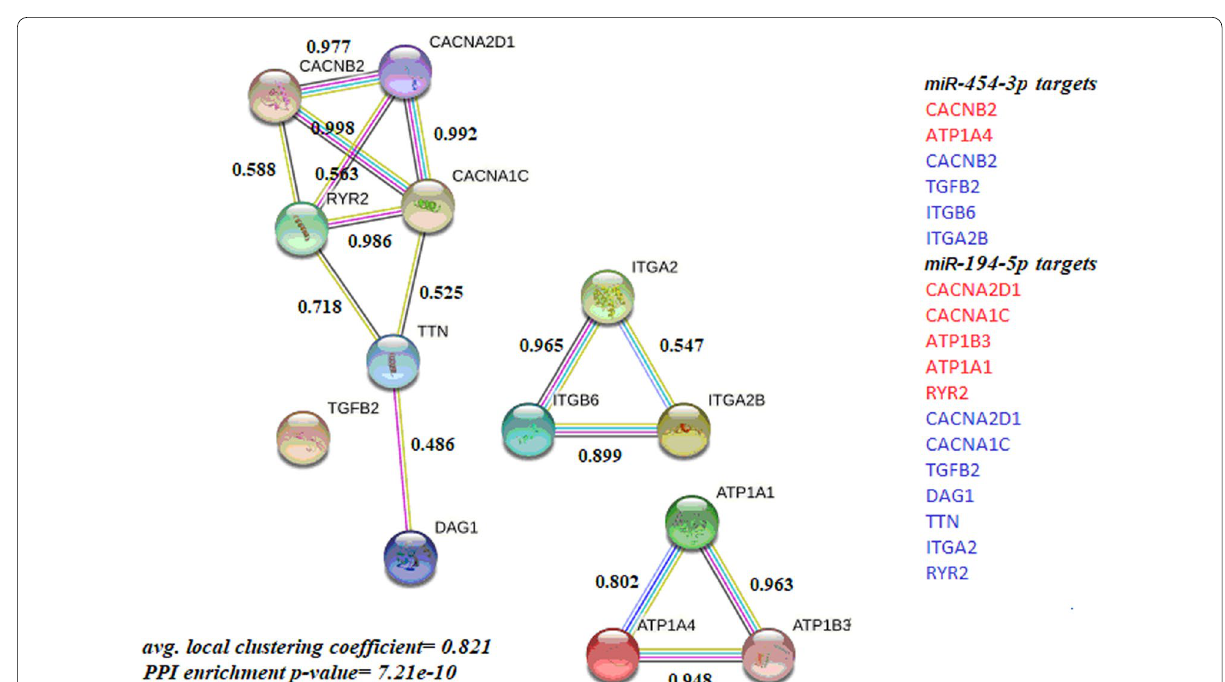
Fig. 3 PPI enrichment network for the whole target genes including interaction score on edges lines. On the right column, proteins by red highlighted refer to cardiac muscle contraction pathway relevant targets and by blue highlighted refer to DCM pathway relevant targets. PPI enrichment p value of miR‑454‑3p 0.181, PPI enrichment p value of miR‑194‑5p = =